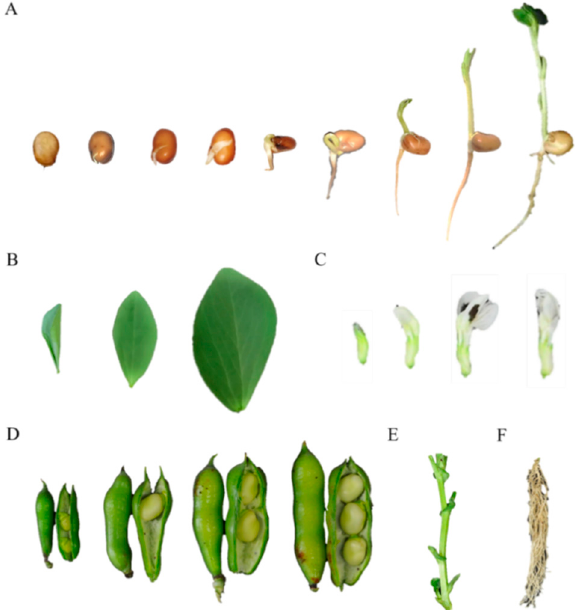
Figure 1. Morphology of faba plant tissues. ( A ) Faba bean sprouts from left to right: 1 to 8 and 12 days after germination, respectively; ( B ) Leaves from left to right are new (collected from the first node), young (collected from 2–4 nodes), and old leaves (collected from the base of the plant), respectively; ( C ) Flowers from left to right are flower bud (S1), young flower (S2), fully opened flower (S3), and senescent flower (S4), respectively; ( D ) Pods from left to right are S1 to S4, respectively, ( E ) Stem, and ( F ) Root.